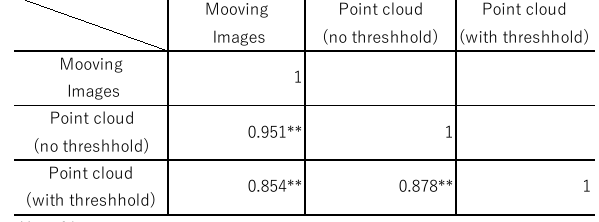
Table 3 . The correlation matrix for the scores by VQM